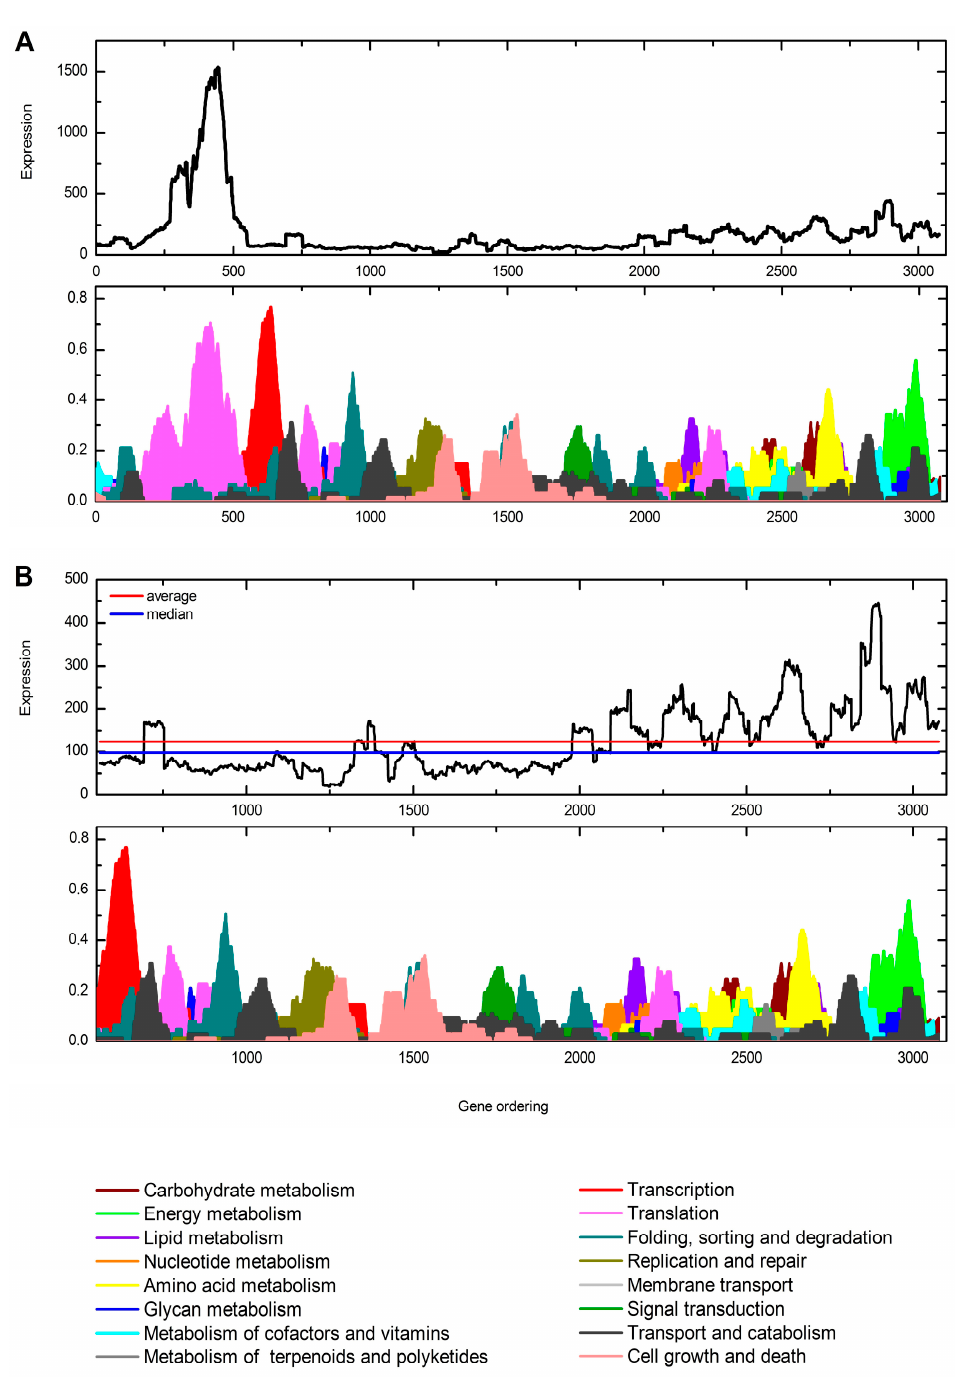
Figure 4. Transcriptogram of BAL RNA-Seq data of C. gattii R265. The upper graph shows the expression values (y) of ordered genes (x). The bottom graph indicates the KEGG pathways related to the ordered genes. ( A ) Complete transcriptogram; and ( B ) transcriptogram with the median and average expression values.